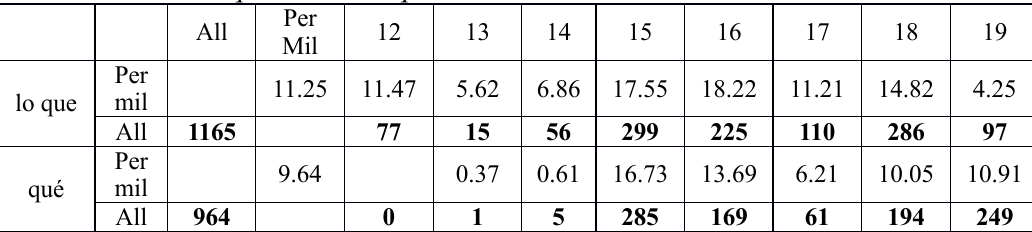
Table 3: saber lo que vs. saber qué